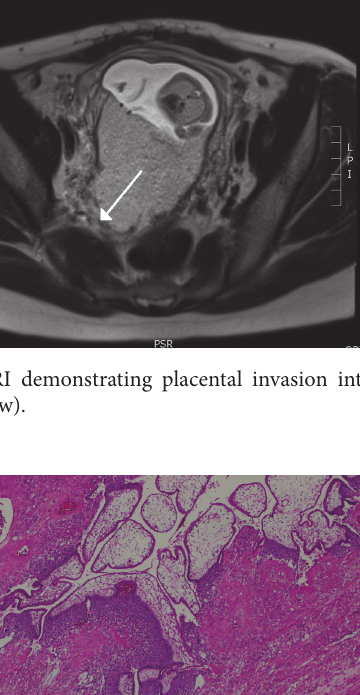
Figure2:Elastogramdemonstratingnormalplacenta-myometrium interface.